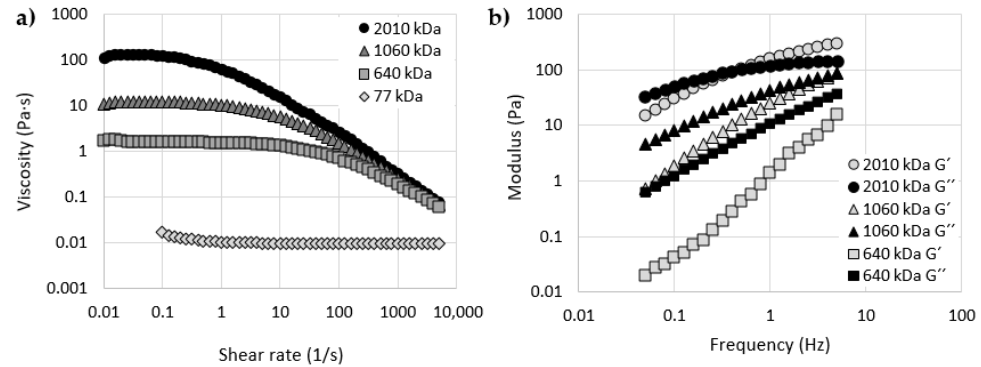
Figure 2. ( a ) Viscosity as a function of shear rate for HA solutions with different molecular weights; ( b ) Elastic (G´) and viscous (G´´) moduli as a function of frequency for HA solutions with different ( b ) Elastic (G (cid:48) ) and viscous (G”) moduli as a function of frequency for HA solutions with di ff erent molecular weights. molecular weights. Table 1. Rheological properties of tested HA